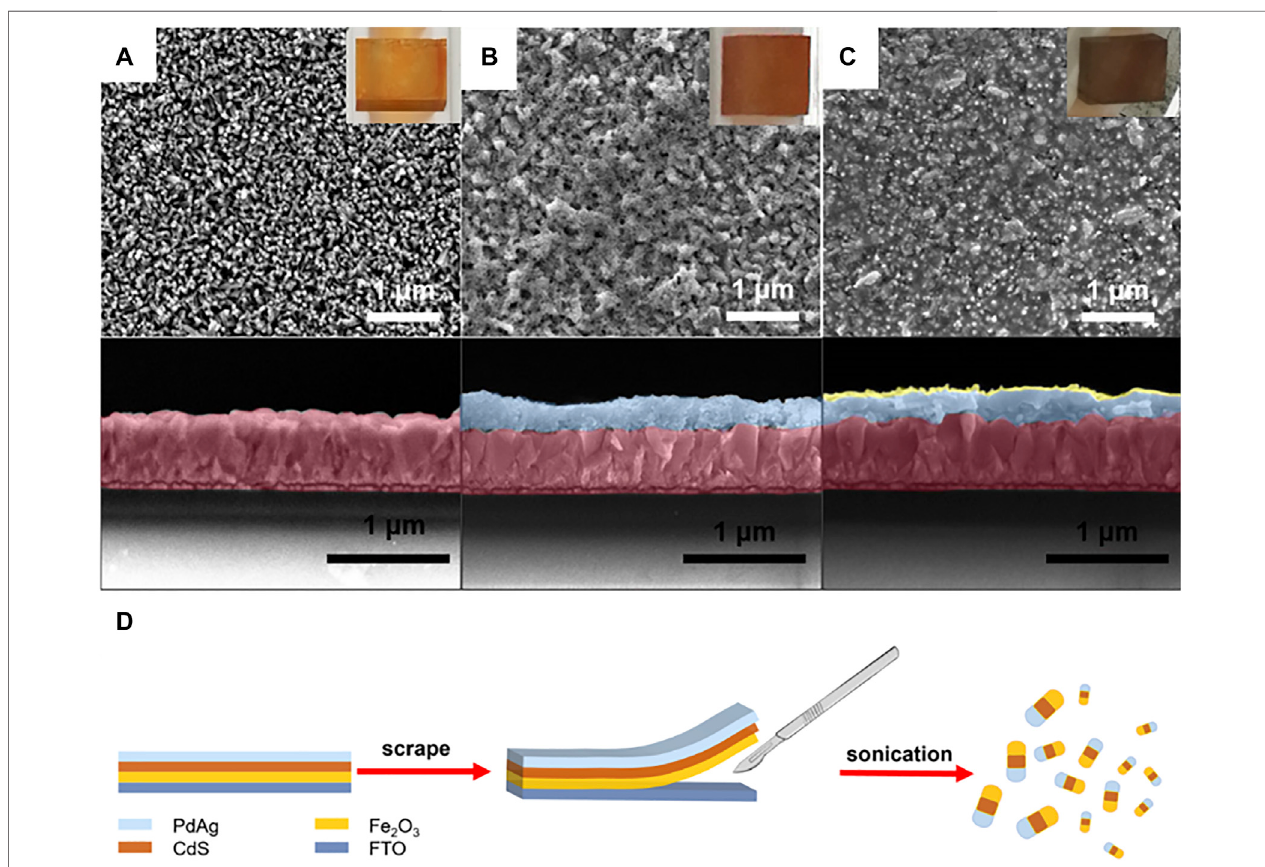
FIGURE1| SEMimagesofthetopview,cross-section,anddigitalphotographsof (A) α -Fe 2 O 3 , (B) α -Fe 2 O 3 /CdS, (C) α -Fe 2 O 3 /CdS/PdAgonFTOsubstrates,and (D) schematic diagram of a process for preparing samples for CO 2 reduction tests.